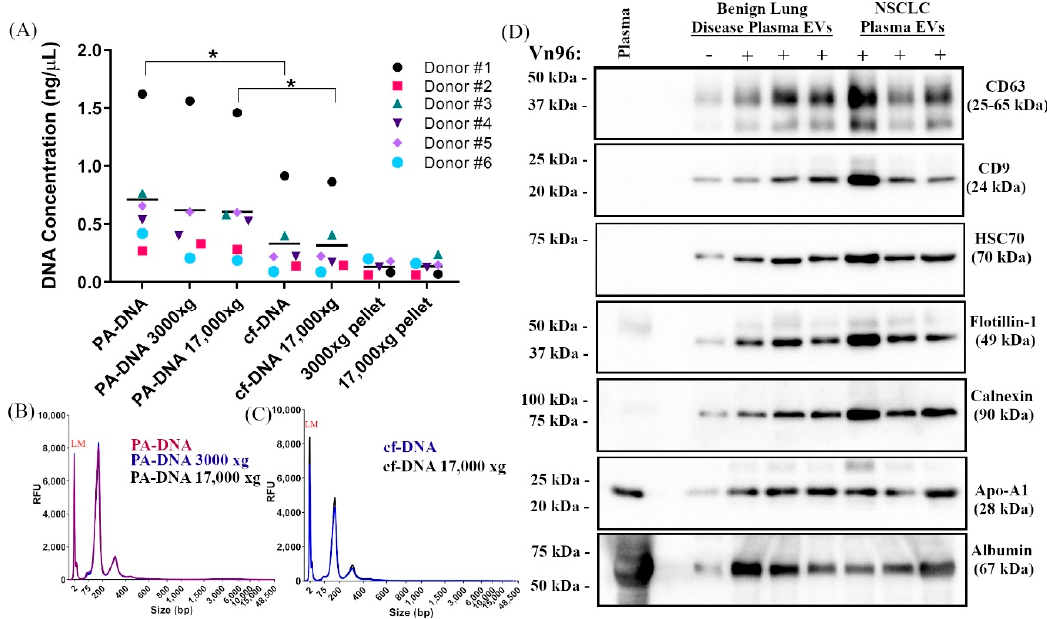
Figure 1. Effect of plasma pre-clearing on DNA recovery and detection of EV markers in PA precipitated material. ( A ) Plasma from six NSCLC donors was either not pre-cleared, or pre-cleared at 3000× g or 17,000× g for 15 min. The post-centrifugation pellet was retained, resuspended in nuclease-free water and DNA was extracted. Peptide affinity (PA) precipitation was performed on equivalent volumes of either non-precleared or pre-cleared plasma and DNA (PA-DNA) was isolated using the Plasma/Serum Cell-Free Circulating DNA Purification Mini Kit (Norgen Biotek). Cell-free DNA (cf-DNA) was obtained from equivalent volumes of plasma using the same DNA isolation kit for comparison ( n = 6; * p < 0.05). A representative overlay of the DNA profiles of ( B ) PA-DNA or ( C ) cf-DNA from plasma (Donor #1) using either no pre-clearing or 3000× g or 17,000× g pre-clearing is shown (LM = lower marker). ( D ) A representative western blot ( n = 3) of Vn96 PA precipitated material from 1 mL of plasma from donors with benign lung disease or NSCLC is shown. Canonical EV markers CD63, CD9, HSC70, and flotillin-1 were detected using specific antibodies. A vehicle control sample (without Vn96) was included as a negative control ( − ). In addition, calnexin, apolipoprotein A1 (Apo-A1), and albumin, which are common co-contaminants included as a positive control for non-EV-associated plasma